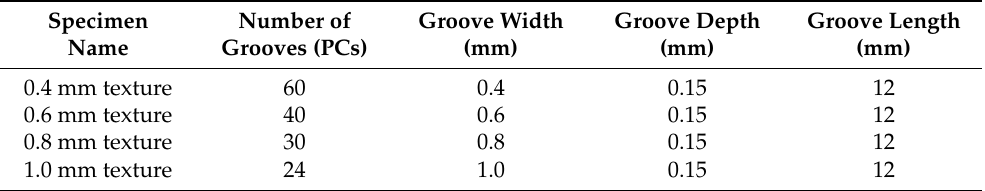
Table 2. Dimensional parameters of the prepared texture specimen.